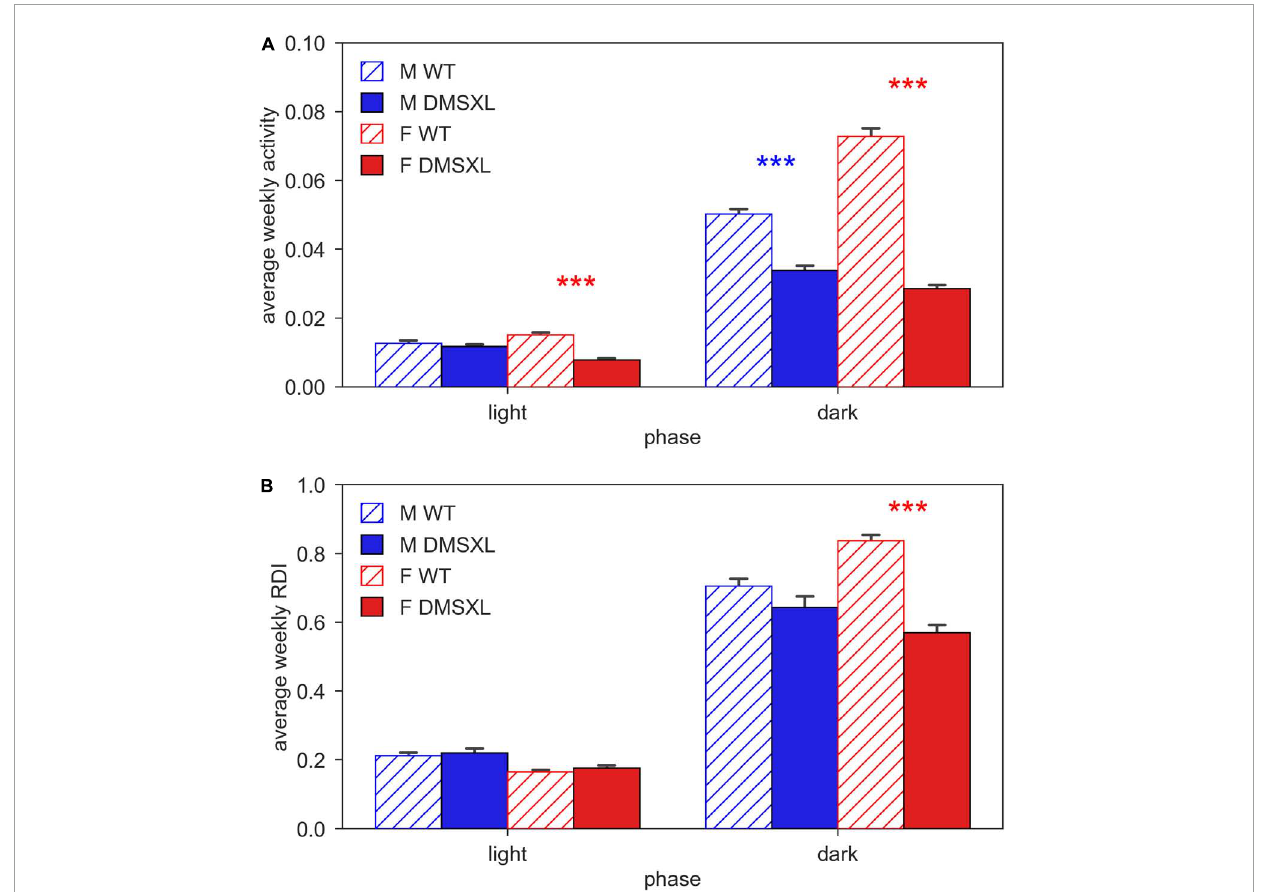
FIGURE2 Activity and regularity disruption index (RDI) during light and dark phase. Panel (A) shows the average weekly activity ( ± SEM) and panel (B) shows the average weekly RDI ( ± SEM), both over light and dark phases across the 5 weeks of experiment in male (M, blue) and female (F, red) cages of wild-type (WT) (diagonal lines) and DMSXL (filled bar) mice. N of cages per group: M WT = 10; M DMSXL = 10; F WT = 11; F DMSXL = 8. Bonferroni-corrected post-hoc tests to compare DMSXL and WT males (blue asterisks), and DMSXL and WT females (red asterisks), (*** p < 0.001 nparLD test with genotype and week